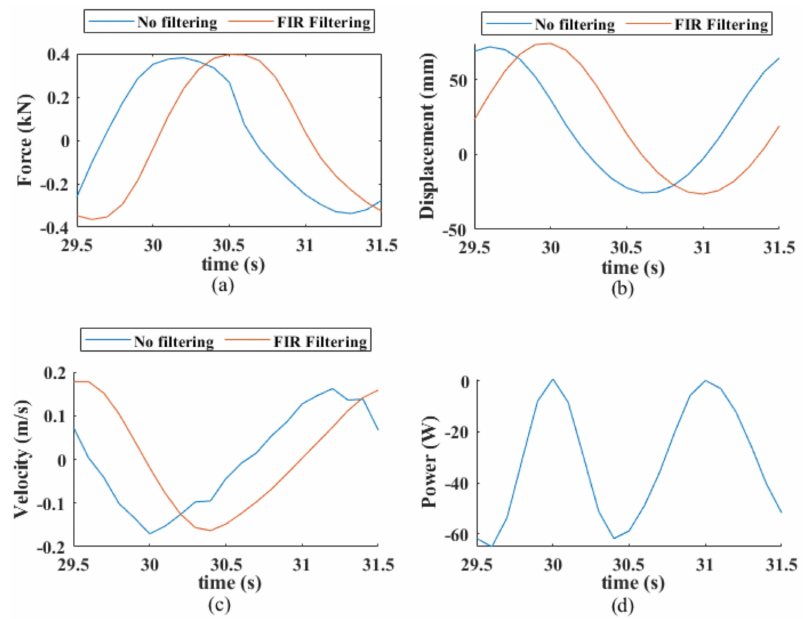
Figure 15. Typical generator input waveforms of ( a ) buoy force; ( b ) translator position; ( c ) translator velocity and ( d ) Mecahnical power (average = − 27.1 W). H = 0.2 m, f = 0.5 Hz, B ePTO = 1200 Ns/m. Negative power represents generated electricity.